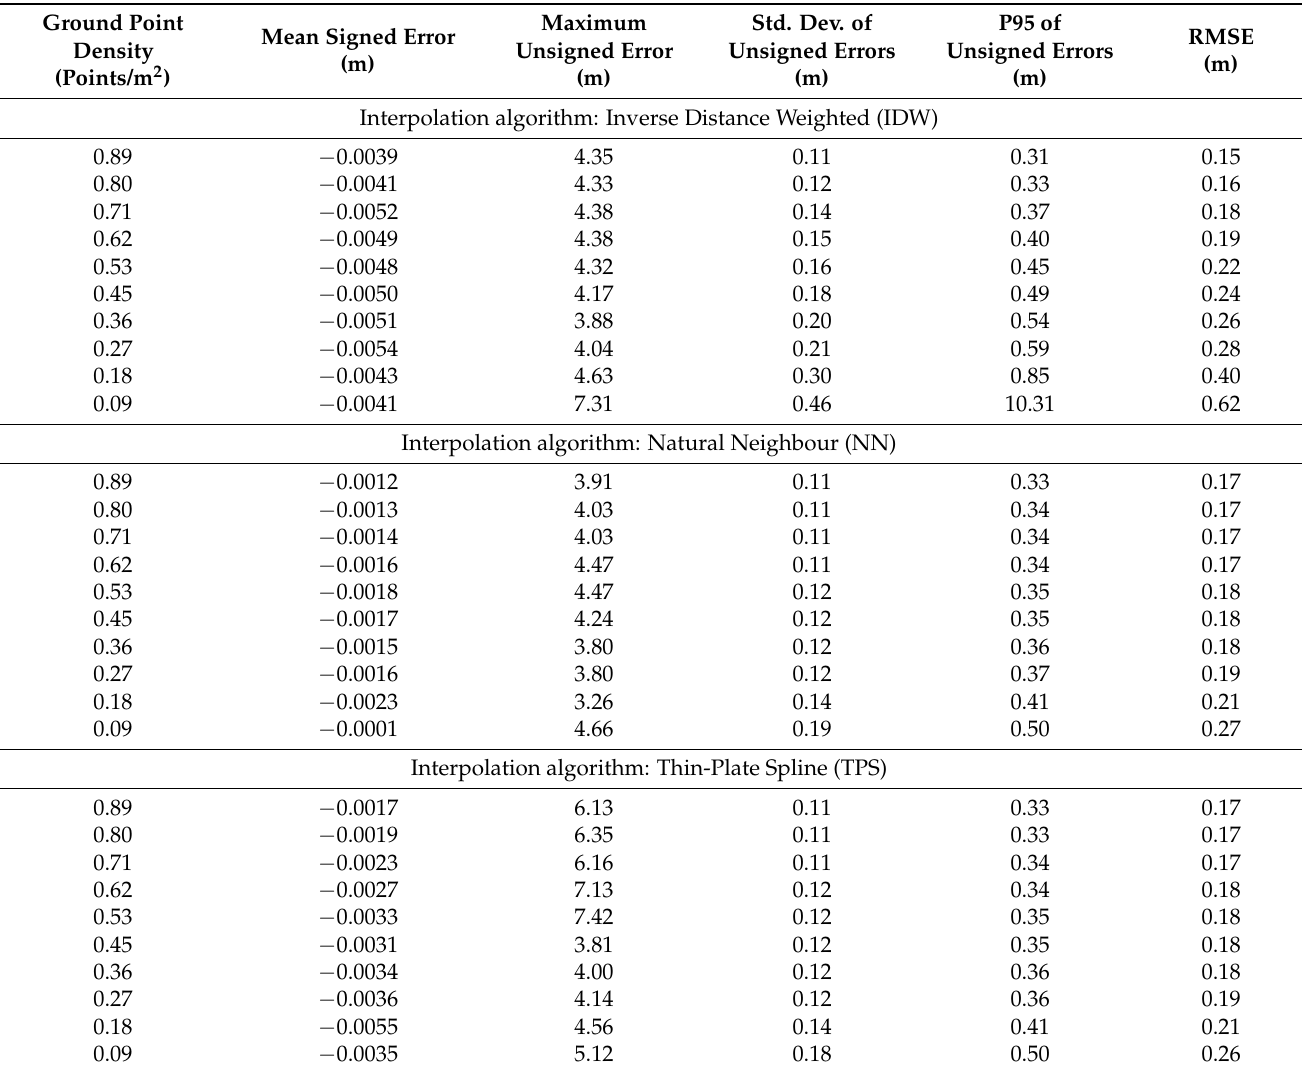
Table 1. DTM accuracy at various point